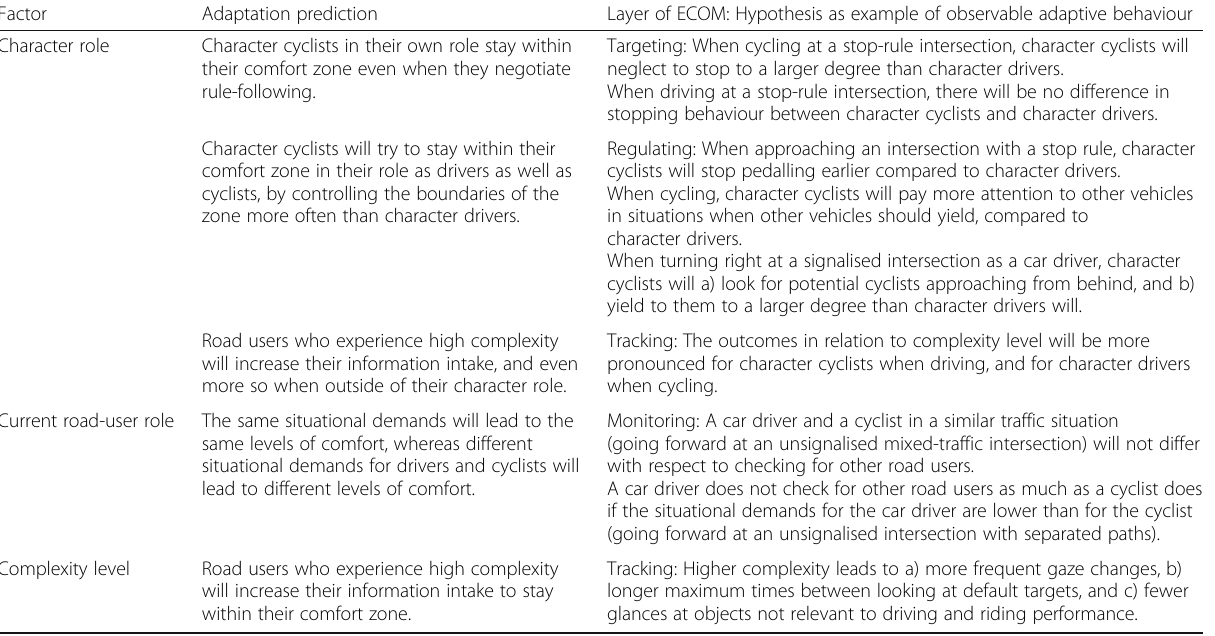
Table 1 Factors investigated in the study, together with adaptation predictions and the corresponding layer in ECOM Factor Adaptation